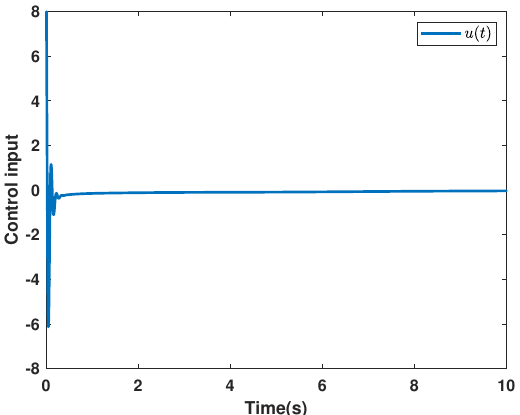
Figure 10. Adaptive SMC law u ( t ) .